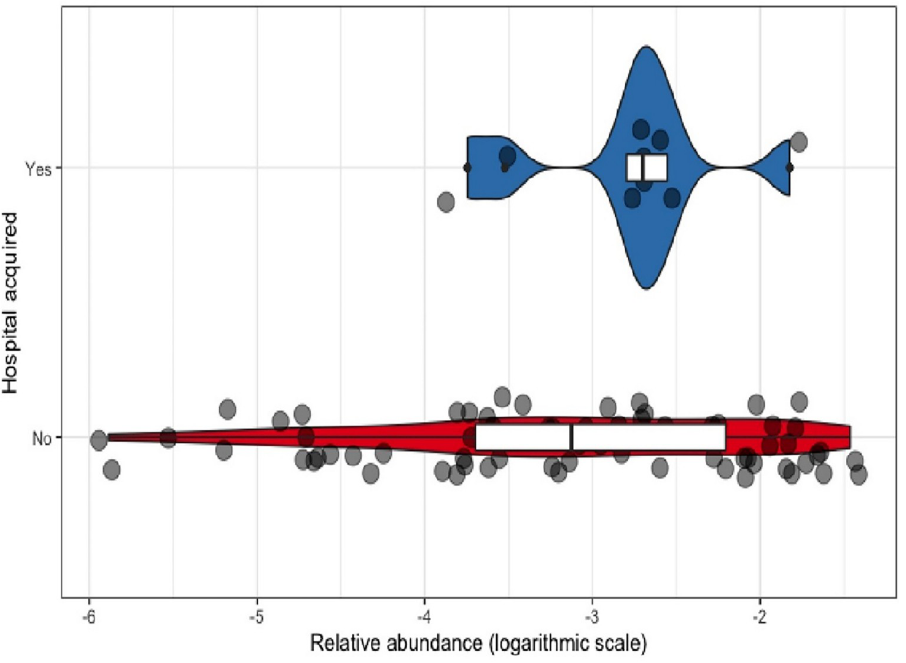
Fig 11. CRE relative abundance of community-acquired and hospital-acquired CRE.